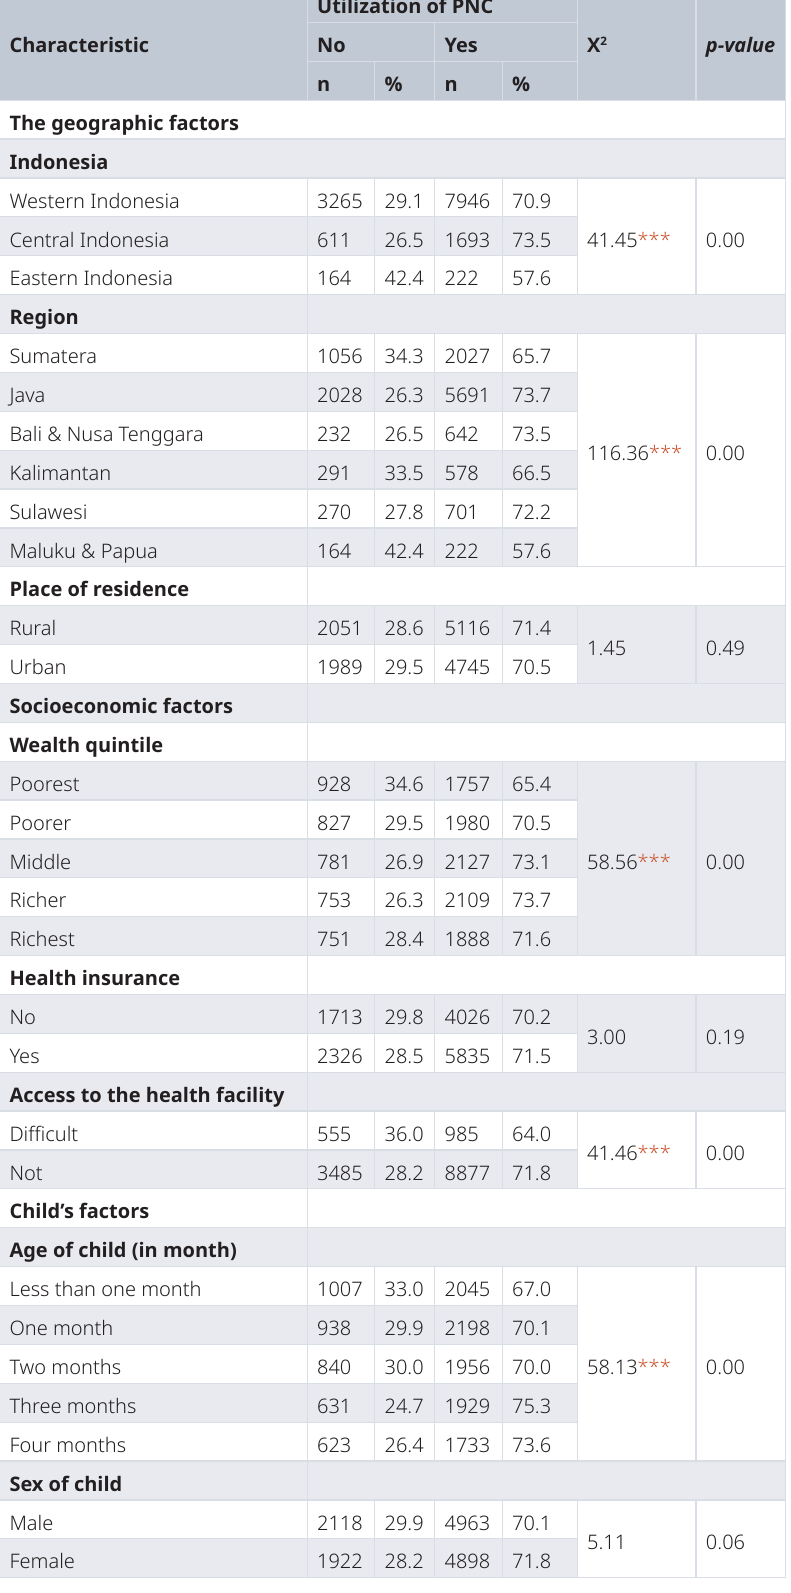
Table 1. Socio-demographic characteristic of participants by utilization of PNC in Indonesia (n=13,901).